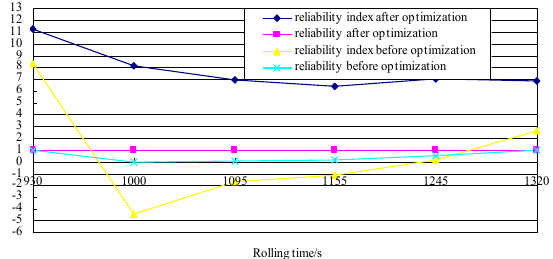
Figure 11. Reliability index, as well as pre- and post-optimization reliability associated with the third rolling pass.